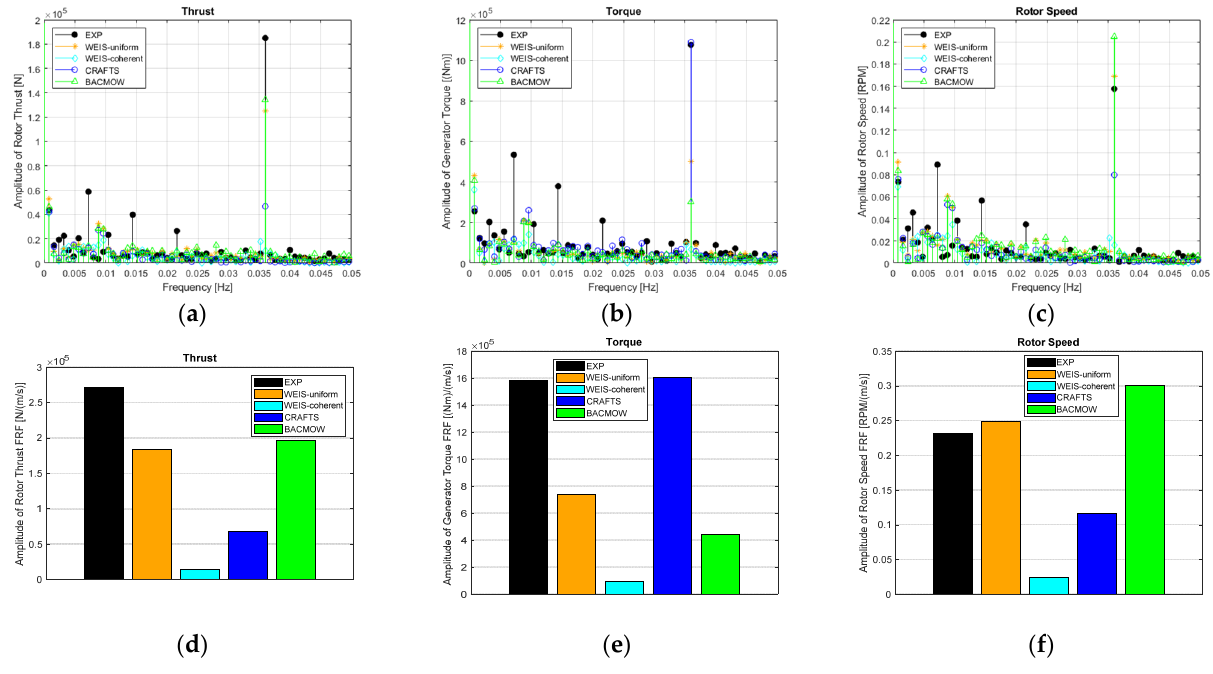
Figure 15. LC 3.4 frequency response functions for thrust, torque, and rotor speed: frequencies ( a – c ) and amplitudes ( d – f ).